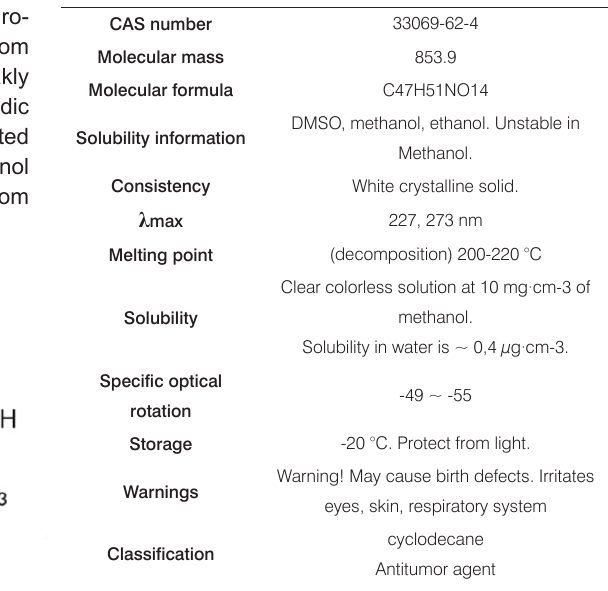
Table 1. General characteristics of paclitaxel